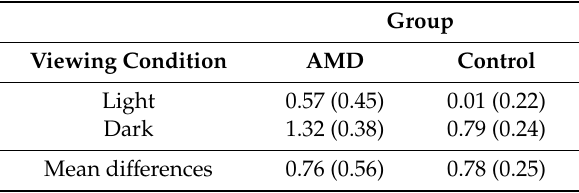
Table 2. Mean eye position stability [log 10 BCEA (deg 2 )] for the two groups. Values in parentheses are ± 1